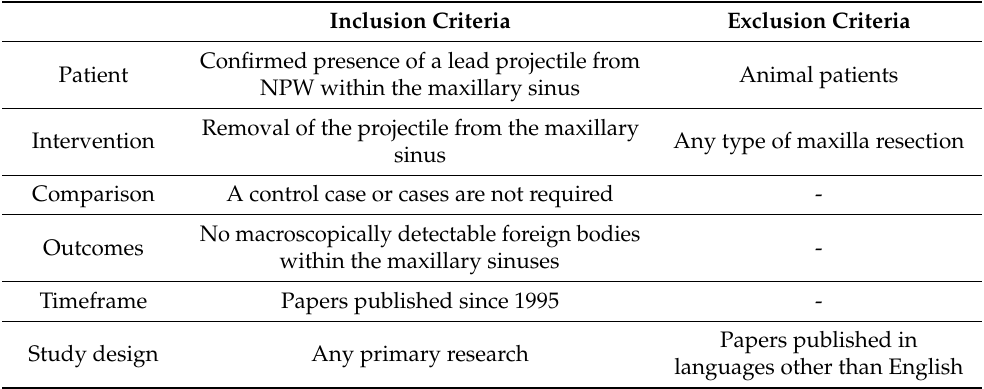
Table 1. Eligibility criteria for articles constituting material for the systematic review. PICOTS framework was adapted [6].